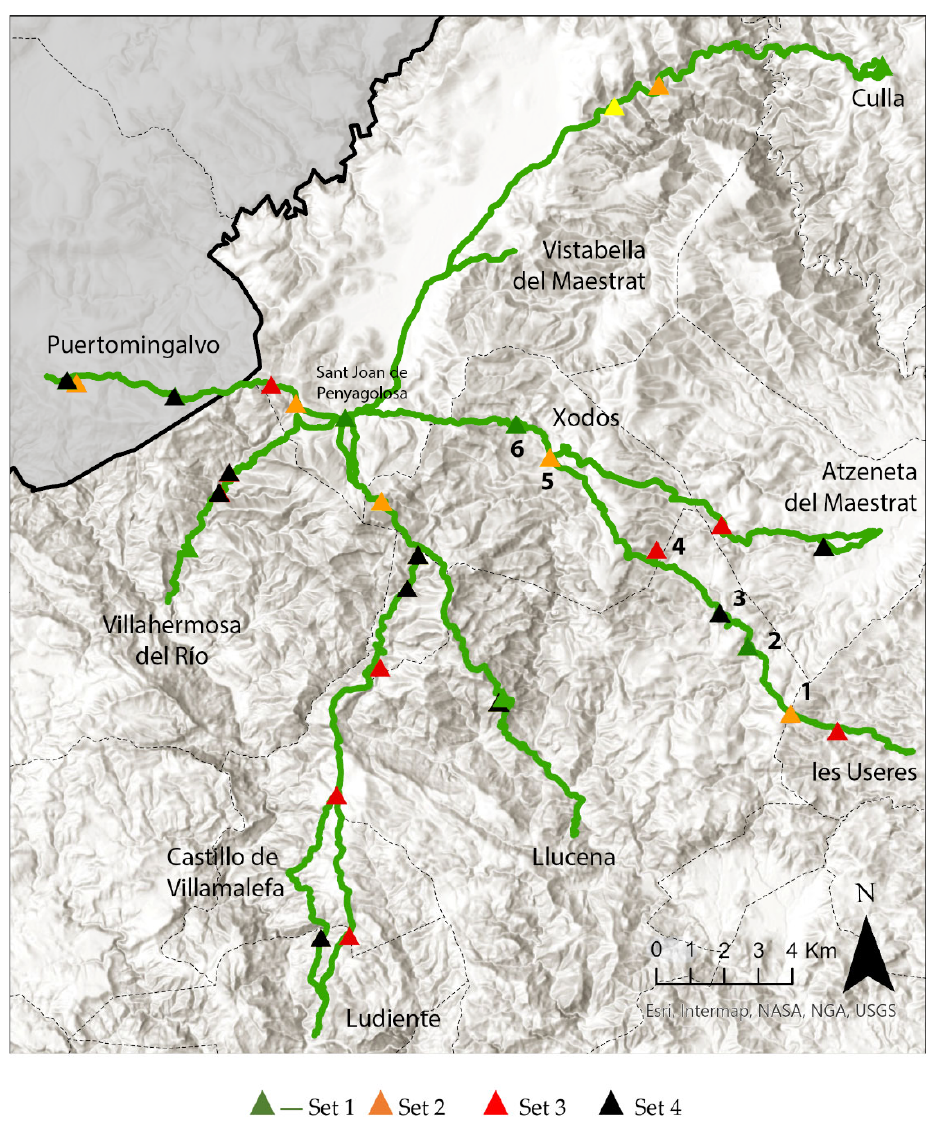
Figure 9. Settings of cultural and natural value. Source: authors.